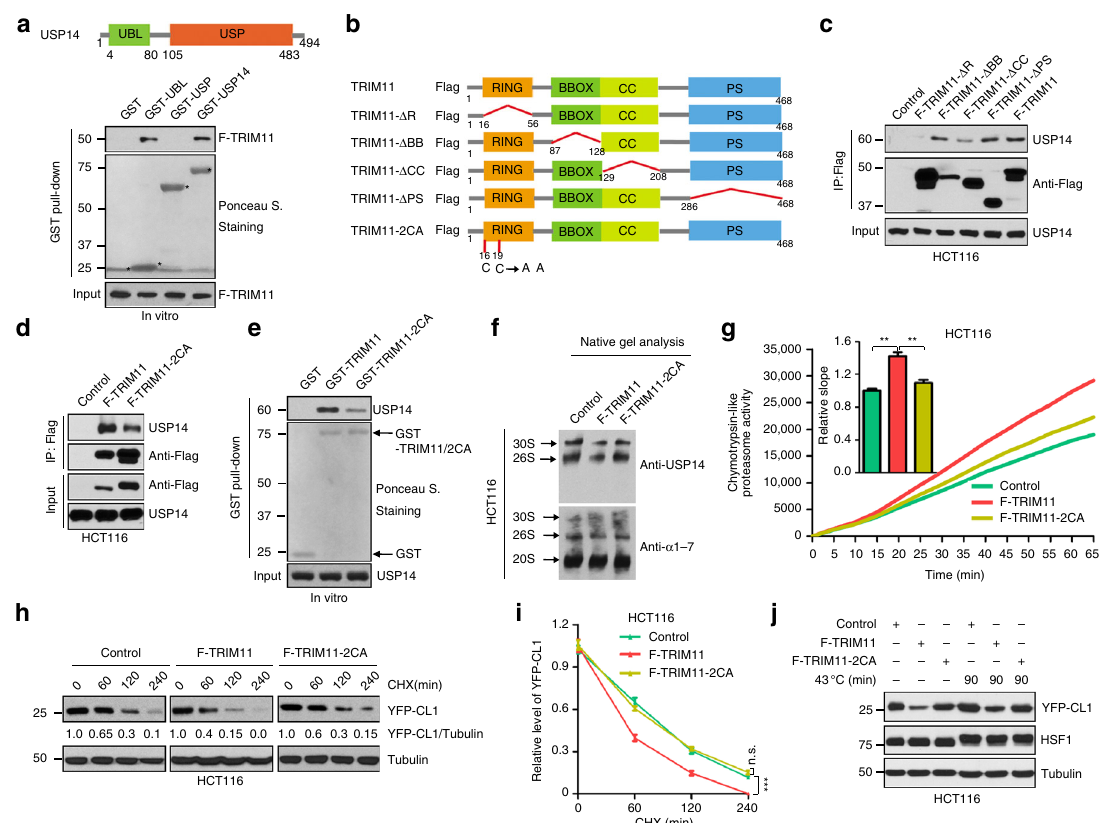
Fig. 6 Structure determinants of the USP14-TRIM11 interaction. a Top: schematic diagram of USP14. The ubiquitin-like (UBL) and ubiquitin-speci fi c protease (USP) domains, as well as the numbers of amino acids, are indicated. Bottom: interaction of the USP14 UBL domain with TRIM11. Beads- conjugated GST or GST-USP14 (2 μ g each) was incubated with Flag-TRIM11 (1 μ g). The input and beads-bound proteins were analyzed by western blot with anti-Flag antibody or Ponceau S staining. Asterisk indicates GST and GST fusions. b Schematic diagram of TRIM11 and its mutants. In TRIM11-2CA, the conserved Cys16 and Cys19 were mutated to Ala. Each construct was tagged with Flag epitope. c , d Interaction of Flag-TRIM11 proteins with endogenous USP14 in HCT116 cells was analyzed by co-IP assay. e Interaction of USP14 (2 μ g) with GST, GST-TRIM11, and GST-TRIM11-2CA (1 μ g each) was analyzed by in vitro pull-down assay. f Cell Lysate fractions enriched with the proteasomes were isolated from control, Flag-TRIM11-expressing, and Flag-TRIM11- 2CA-expressing HCT116 cells, and analyzed by native gel electrophoresis and immunoblotting using α 1-7 and USP14 antibodies. g Chymotrypsin-like proteasome activity in control, Flag-TRIM11-expressing, and Flag-TRIM11-2CA-expressing HCT116 cells. Slopes relative to that of vector are also shown (mean ± SEM, n = 8). h , i Half-life of YFP-CL1 in control, TRIM11-expressing, and TRIM11-2CA-expressing HCT116 cells. Representative western blots ( h ) and the relative YFP-CL1/tubulin ratios ( h , i ) are shown. The exposures of the corresponding control and TRIM11/TRIM11-2CA-expressing blots were adjusted to achieve comparable levels of YFP-CL1 at time 0. j Levels of YFP-CL1 in control, TRIM11-expressing, and TRIM11-2CA-expressing HCT116 cells grown under normal and heat stress conditions. In g and i , data represent the mean ± SEM ( n = 3 unless otherwise indicated). ** P < 0.01; *** P < 0.001. Uncropped blots are presented in Supplementary Fig. 13. n.s.: not signi fi